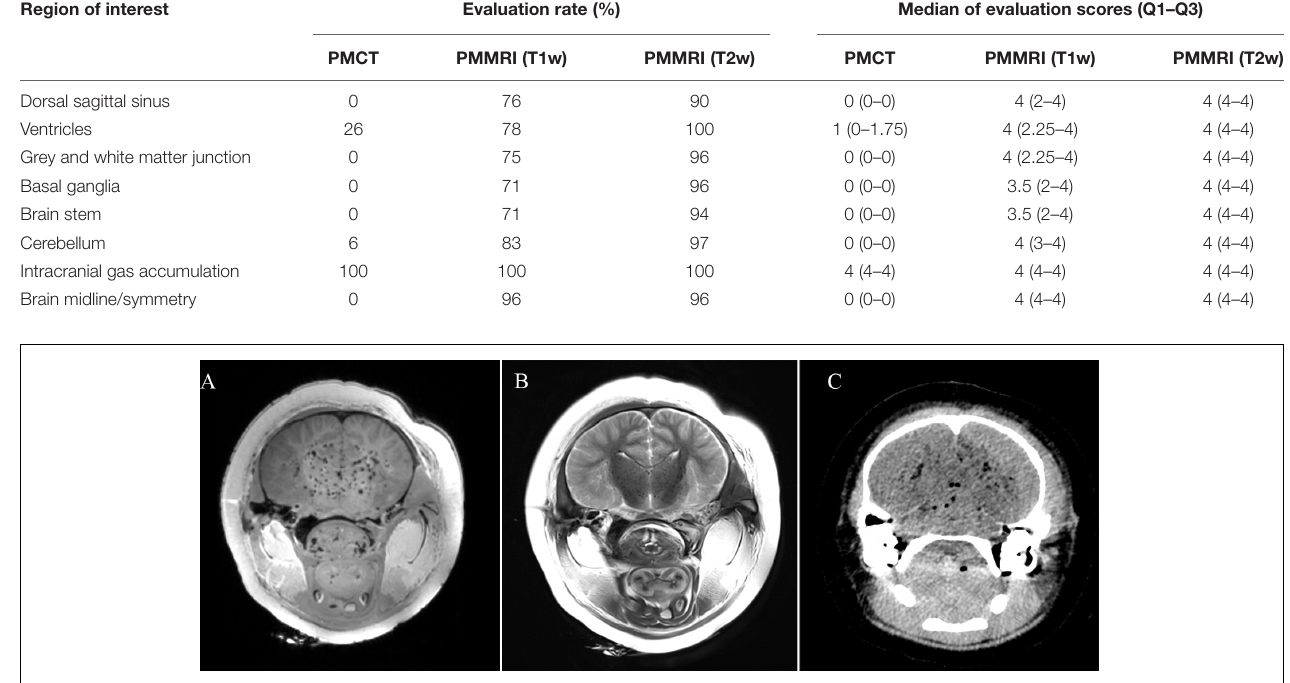
TABLE 2 | Radiological assessment on the eight regions of interest of the cetacean brain using Likert-scale rating. Region of interest